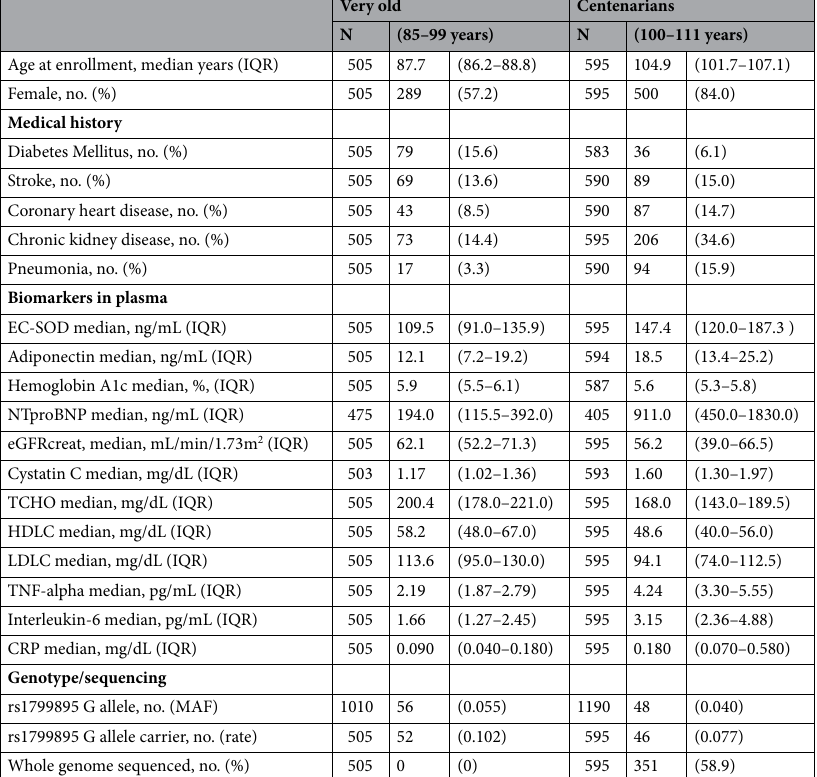
Table 1. Characteristics of participants according to age at enrollment. IQR interquartile range, EC-SOD extracellular superoxide dismutase, NT-proBNP N-terminal pro-brain natriuretic peptide, eGFRcreat estimated glomerular filtration rate based on serum creatinine, TCHO total cholesterol, HDLC high-density lipoprotein cholesterol, LDLC low-density lipoprotein cholesterol, TNF-alpha tumor necrosis factor-alpha, CRP C-reactive protein, MAF minor allele